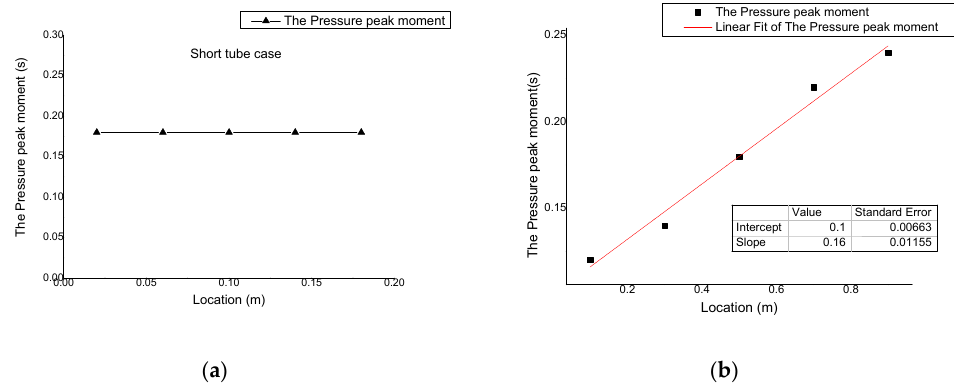
Figure 8. Moments corresponding to the pressure peak and their fitting results: ( a ) peak-occurring moments in short tube example; ( b ) peak-occurring moments in a normal physiology example.